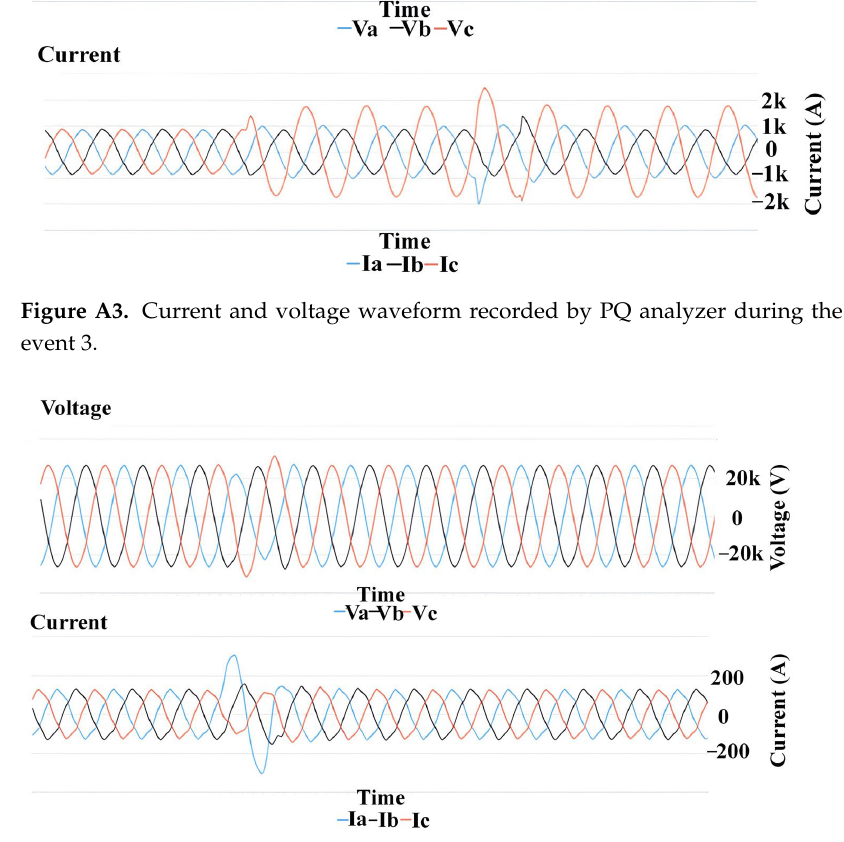
Figure A4. Current and voltage waveform recorded by PQ analyzer during the voltage sag for event 4.